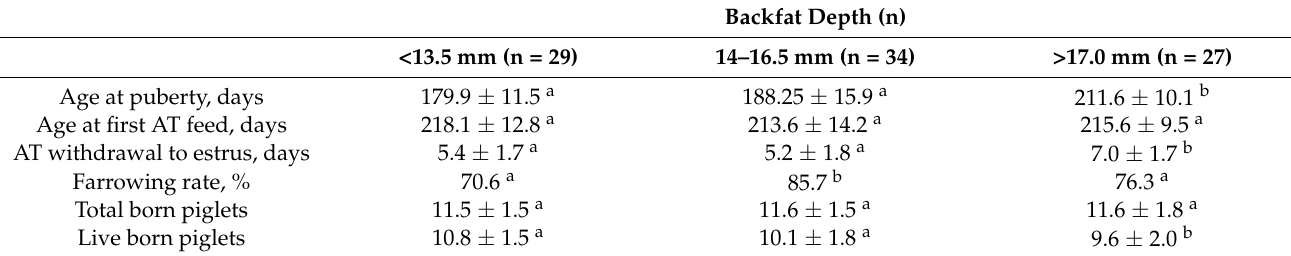
Table 2. Influence of backfat depth at first AT feed on gilt performance (mean ± SD).